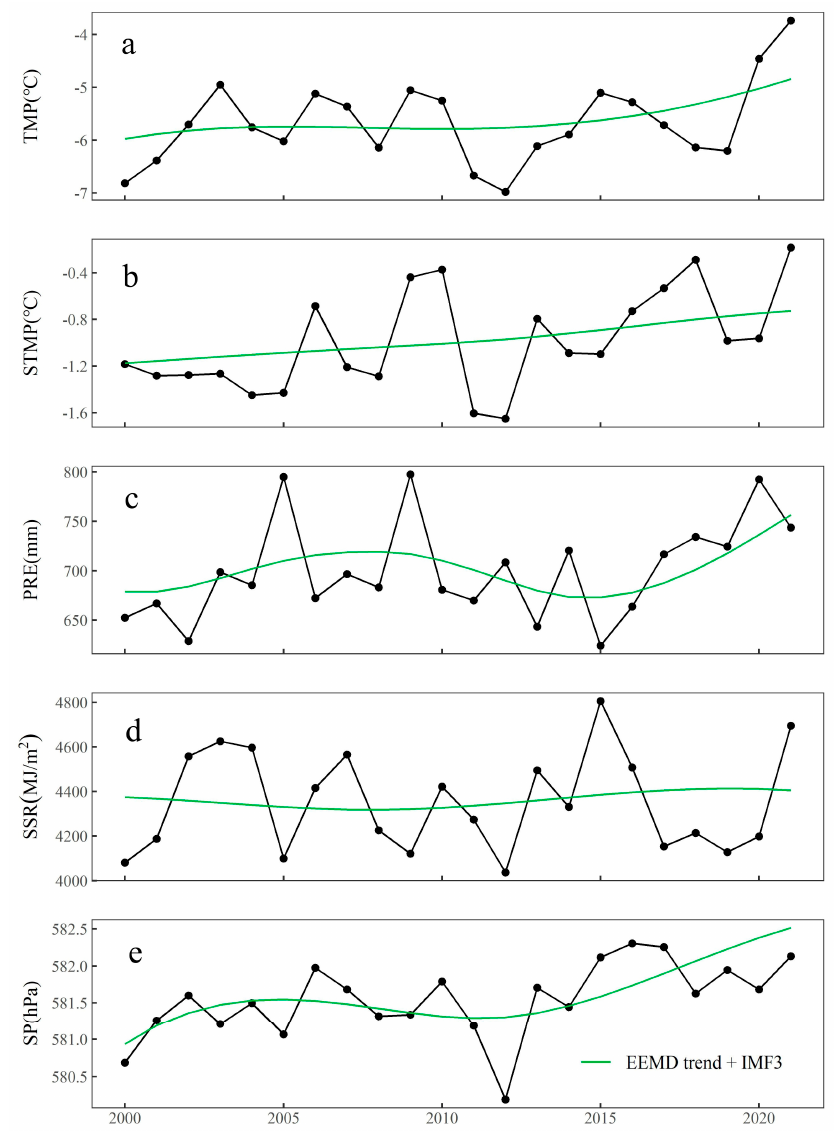
Figure 8. Interannual variations in climatic factors (TMP ( a ), STMP( b ), PRE( c ), SSR( d ), SP ( e )) during 2000–2021.